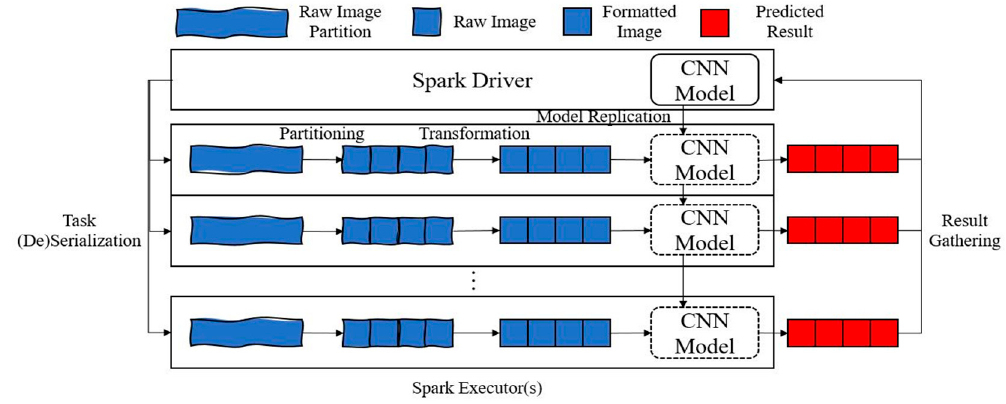
Figure 1. Processing procedure of Spark CNN based on model replication-based data parallelism.